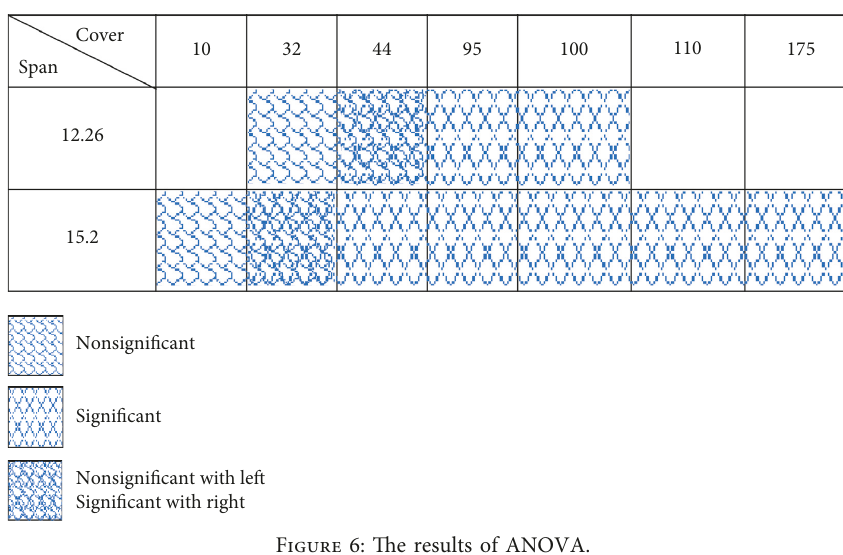
Figure 6: The results of ANOVA.